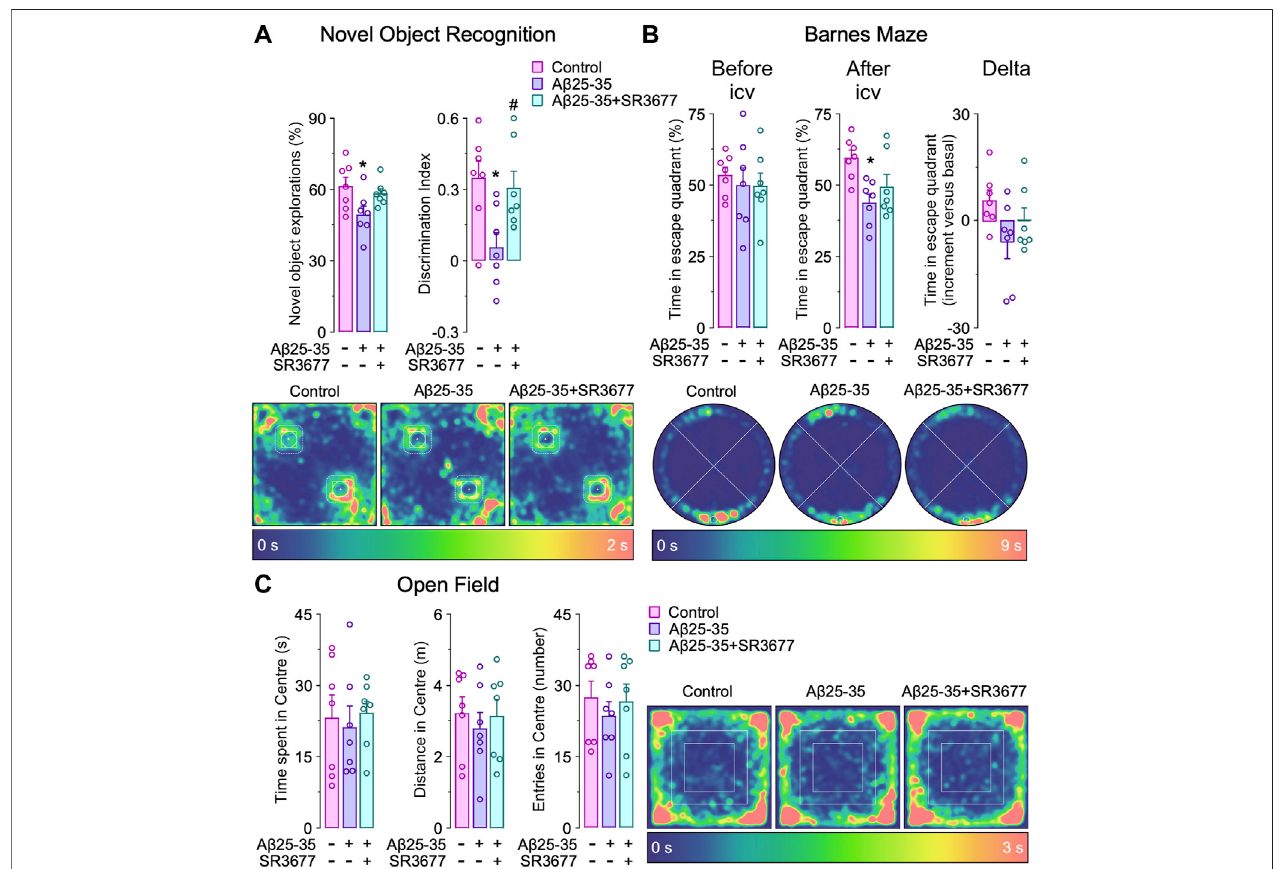
FIGURE 6 | Rock2 inhibition rescues amyloid- β (A β )-induced cognitive impairment in vivo . Intracerebroventricular stereotactic injections of saline (control) or oligomerized A β 25-35 (9 nmol) were performed into 12-week-old male mice. When indicated, Rock2 inhibitor SR3677 (2 mg/kg) was intracerebroventricularly injected togetherwithA β 25-35 oligomers.Behavioraltests wereperformedat 5daysafter injections. (A) Novel object recognitiontest showingnovelobjectexplorationsand the discrimination index (familiar object in the upper left corner, novel object in the lower right corner). Spatiotemporal quantitative heatmaps are shown. (B) Barnes maze test showing time in scape (target) quadrant (lower) before and after A β 25-35 and SR3677 injections ( n = 7 male mice per condition). Spatiotemporal quantitative heatmaps are shown. (C) Open fi eld test showing the time spent, distance and entries in the center area. Spatiotemporal quantitative heatmaps are shown. Data are mean ± SEM from 7 male mice. * p < 0.05 versus control; # p < 0.05 versus A β